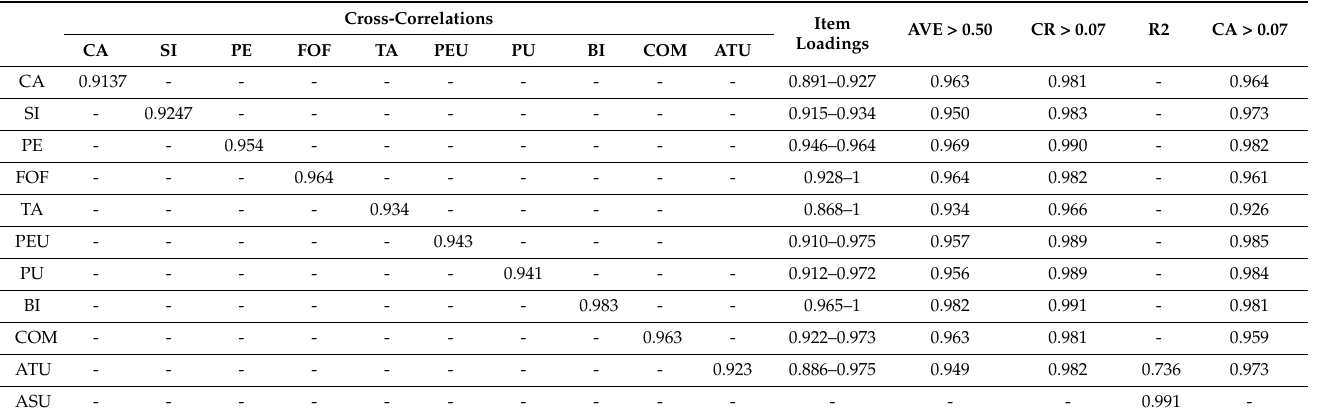
Table 1. Factor correlations, loadings, average variances extracted, R2s of AVE, Cronbach’s alphas, and composite reliabilities of developed research model.